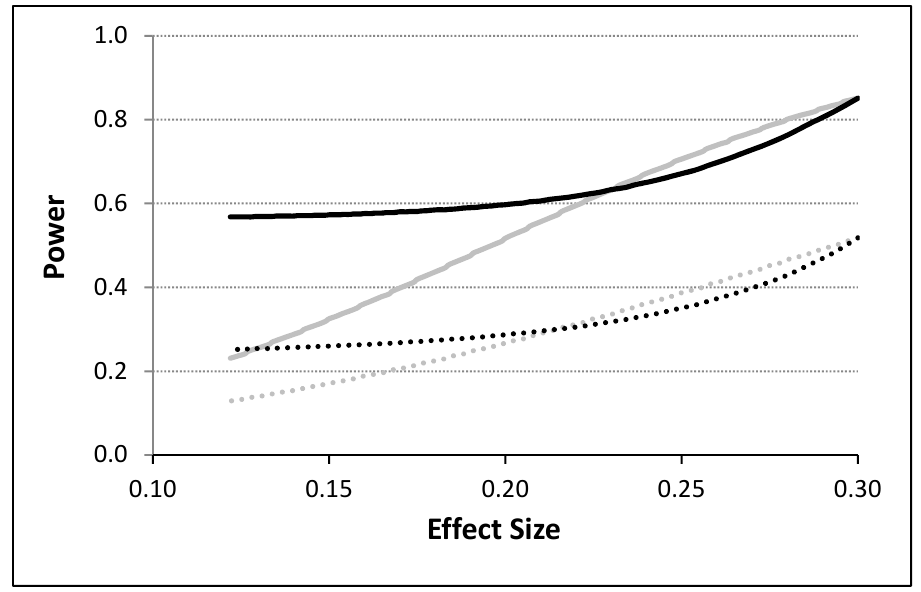
Figure 3. The power to detect the difference between two interventions as a function of the effect size (computed as the difference in means divided by the pooled standard deviation) for serially correlated and potentially heteroskedastic observations based on the proposed analytical model. The gray lines assume equal variances and unequal means and the black lines assume unequal variances. The dashed lines correspond to situations in which a residual serial correlation of 0.5 was assumed and the solid lines correspond to situations in which no residual correlation was assumed. A type I error rate of 0.05 was assumed.